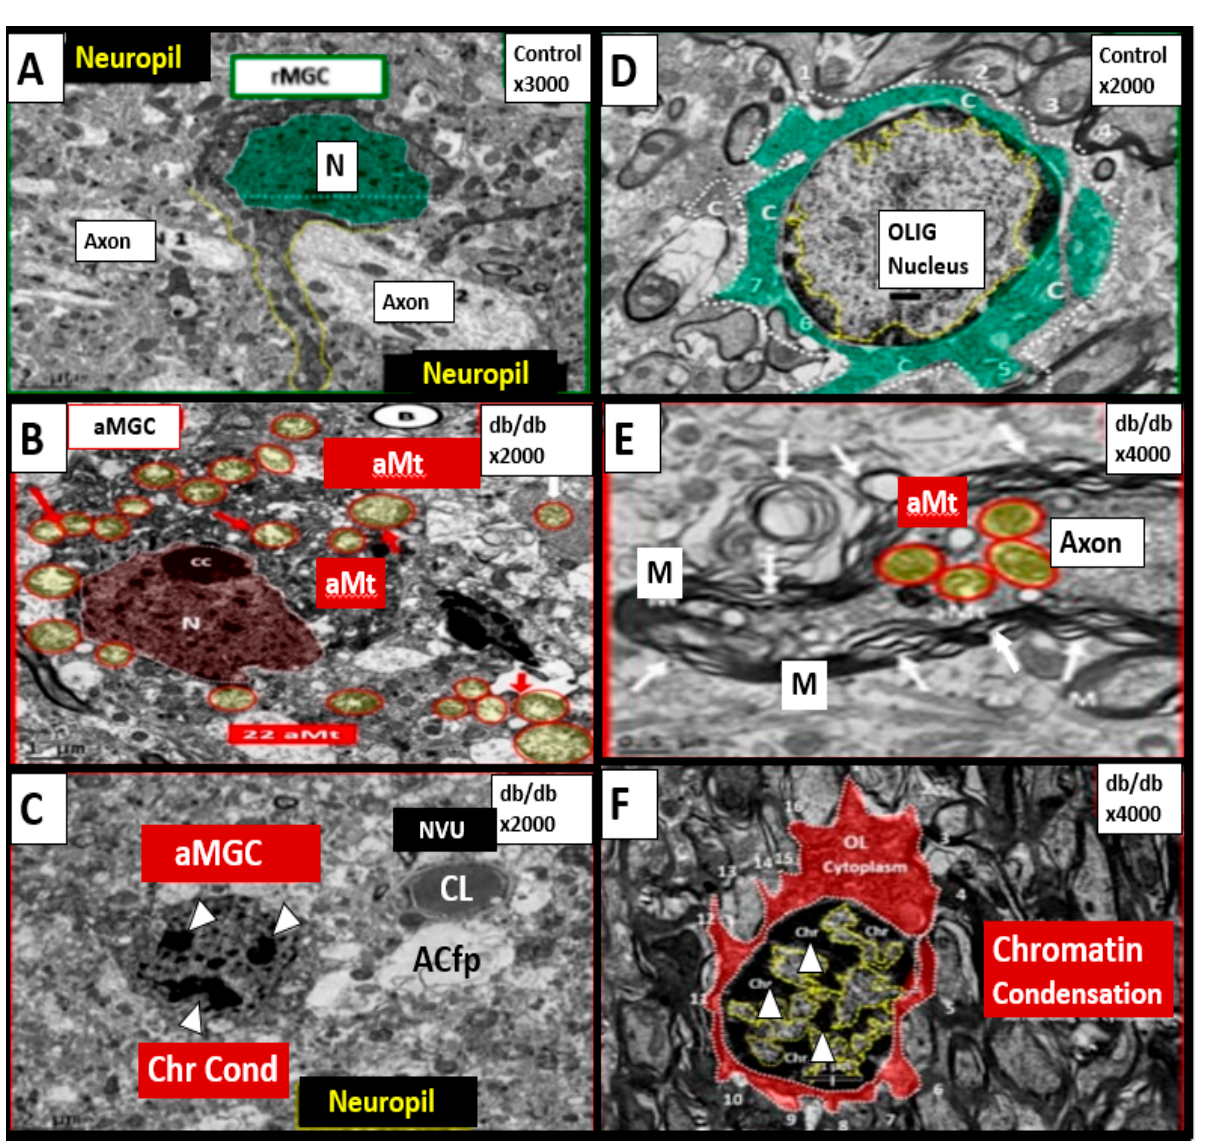
Figure 3. Chromatin Condensation in Aberrant Microglia and Oligodendrocytes in Diabetic Female db/db Models in Grey Matter—Cortical Layer III. This multipanel collage illustrates chromatin condensation in aberrant activated microglia cell(s) (aMGC) and aberrant oligodendrocytes (OL-OLG). Panels ( A , D ) illustrate the normal microglia cell (MGC) and oligodendrocyte in control non-diabetic models respectively. Note the abnormal aberrant mitochondria (aMt) in the microglia and neural cells in panels ( B , E ) respectively with aMt (highlighted yellow circles encircled in red). Panels ( C , F ) depict chromatin condensation (Chr Cond) within the nuclei of aberrant microglial cells and oligodendrocytes respectively. Also, note arrows in panel E depict myelin splitting and separation and arrowheads depict chromatin condensation in the nuclei (panels ( C , F )). aMGCs and aberrant oligodendrocytes suggest abnormal crosstalk with abnormal myelin remodeling and impaired folate one-carbon metabolism. Magnification and scale bar varies. Images in this figure were provided and approved by CC 4.0 [32,33]. M = myelin; N = nucleus; NVU = neurovascular unit; Ol-Olig = oligodendrocyte.